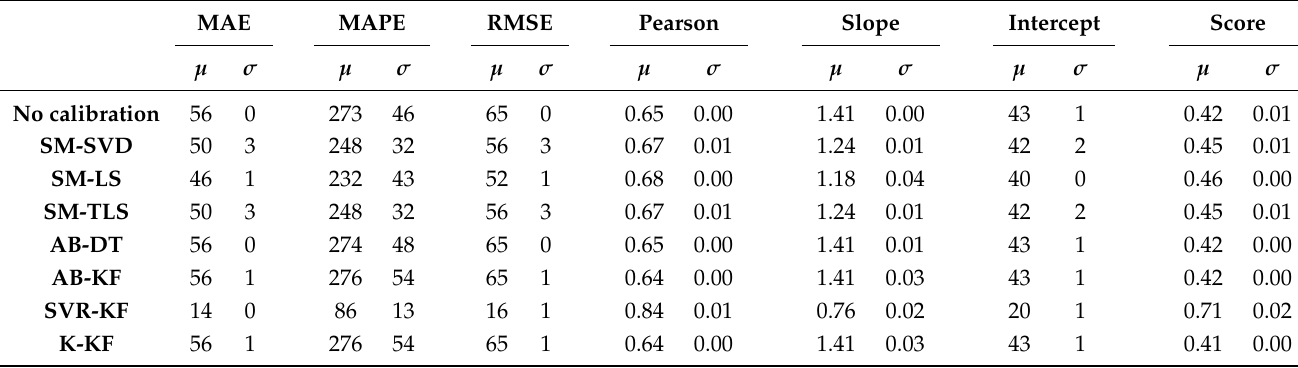
Table 11. Mean and standard deviation of each metric, computed on the entire time interval of study, over the 16 nodes of the network with the RGOI drift model. Results are very different with this model compared to Tables 1 and 4, notably for SM-(SVD, LS, TLS) even if we take into account that we expected to have incorrect offsets.